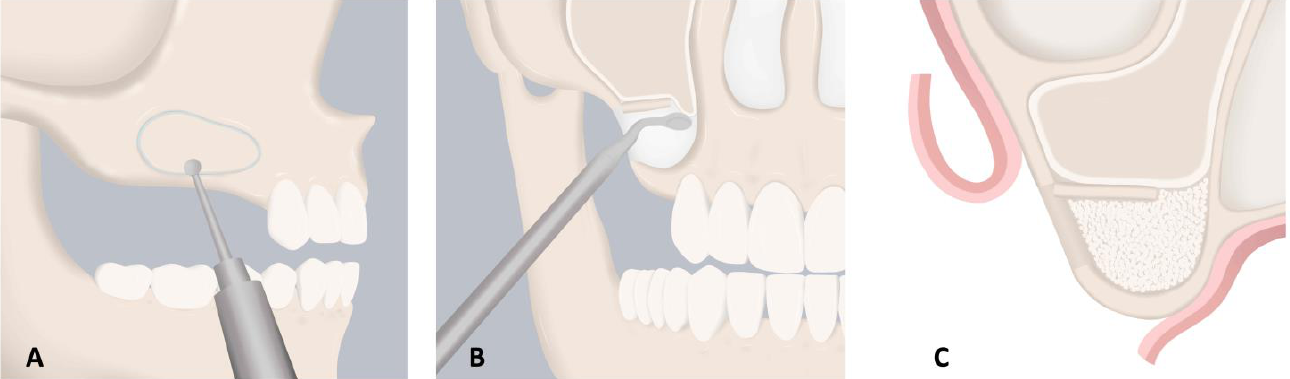
Figure 2. Lateral Window Approach for Maxillary Sinus Augmentation. ( A ) After the full thickness mucoperiosteal flap is raised, the outline of the lateral window is marked with a round bur or piezoelectric surgical tip. ( B ) Before elevating the sinus membrane, the buccal bone is either removed or pushed inward to gain access to the Schneiderian membrane. The membrane is carefully elevated using blunt instruments. ( C ) The sinus compartment is filled with grafting material and covered with resorbable barrier membrane, which can consist of polymeric scaffolds. Reprinted from [99] with permission from Elsevier.